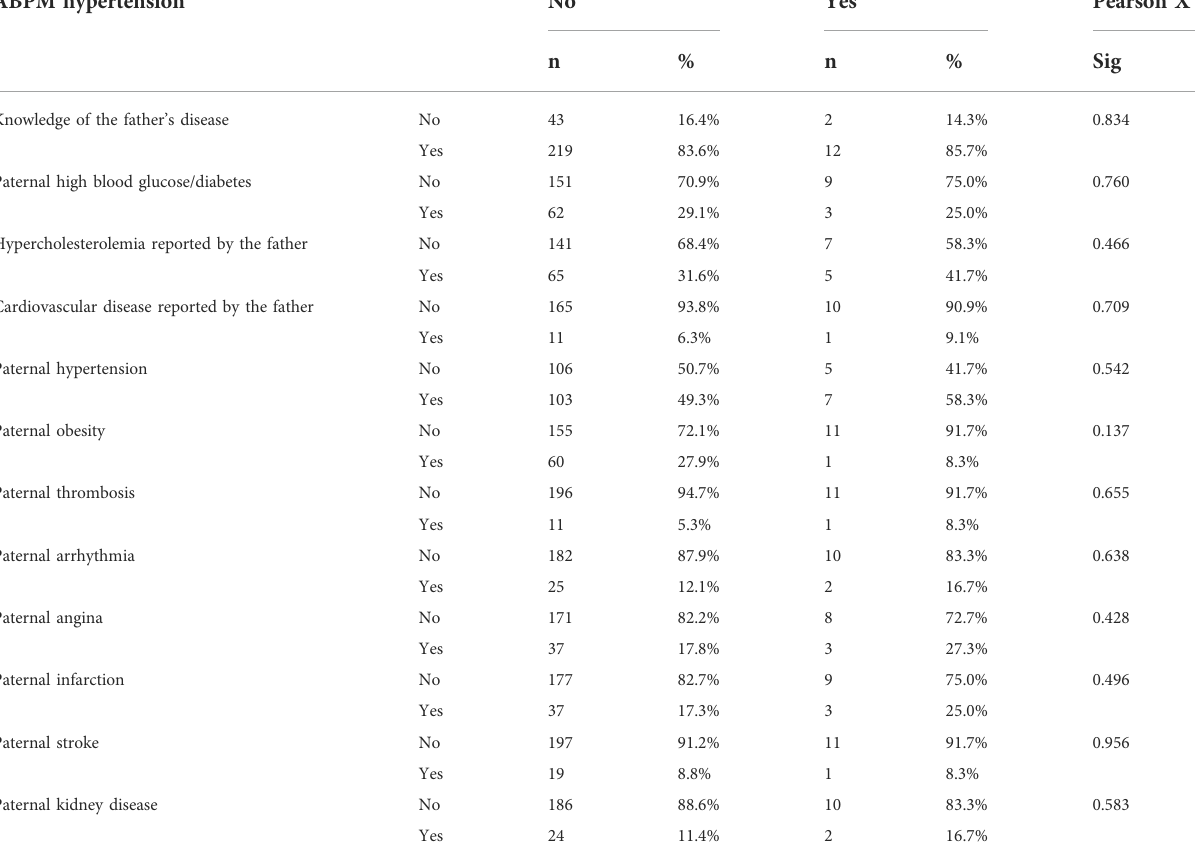
TABLE 4 Evaluation of the presence of hypertension (ABPM) according to paternal